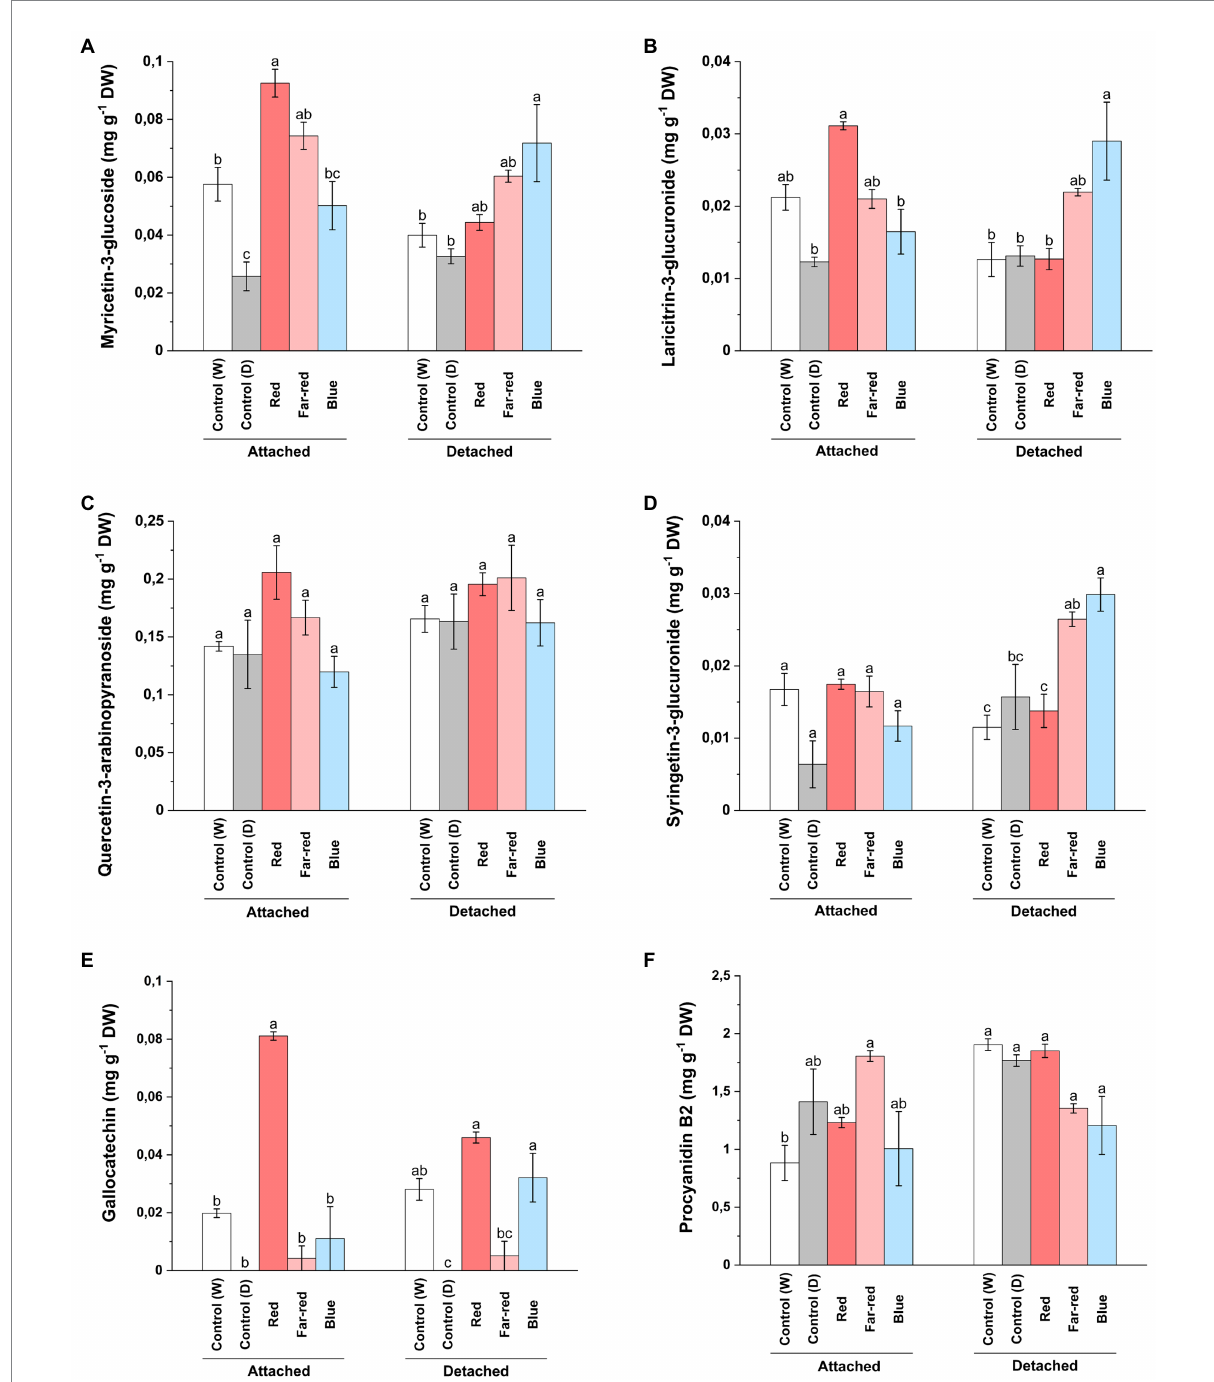
FIGURE 4 Concentrations of myricetin 3-glucoside (A) , laricitrin 3-glucuronide (B) , quercetin-3-arabinopyranoside (C) , syringetin 3-glucuronide (D) , gallocatechin (E) , and procyanidin B2 dimer (F) under different light treatments quantified using LC–MS. The concentrations are expressed in average of three biological replicates ±SE. Different letters indicate significance between the light treatments using ANOVA with pairwise comparisons followed by Tukey’s post-hoc test ( p ≤ 0.05). DW, dry